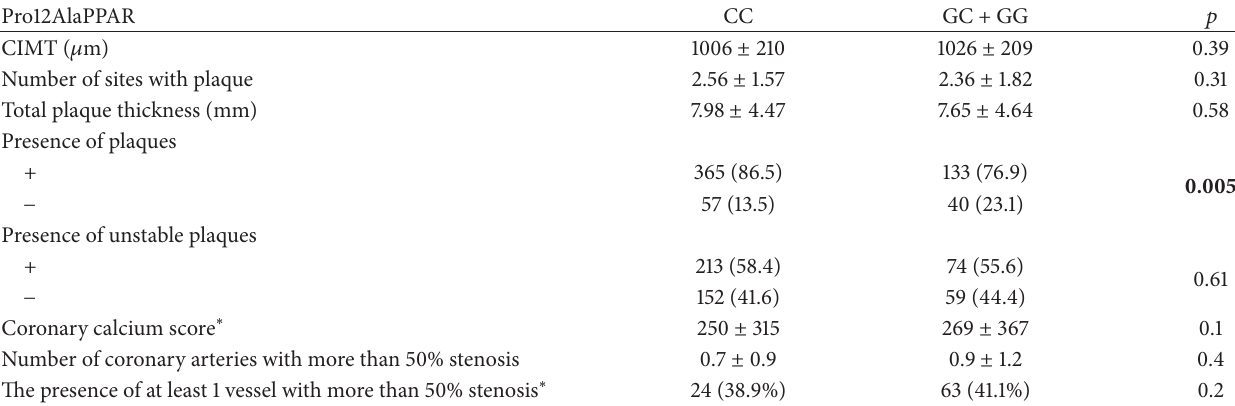
Table 3: Ultrasonographic markers of carotid atherosclerosis due to rs1801282 genotypes in patients with T2DM at the time of recruitment. Pro12AlaPPAR